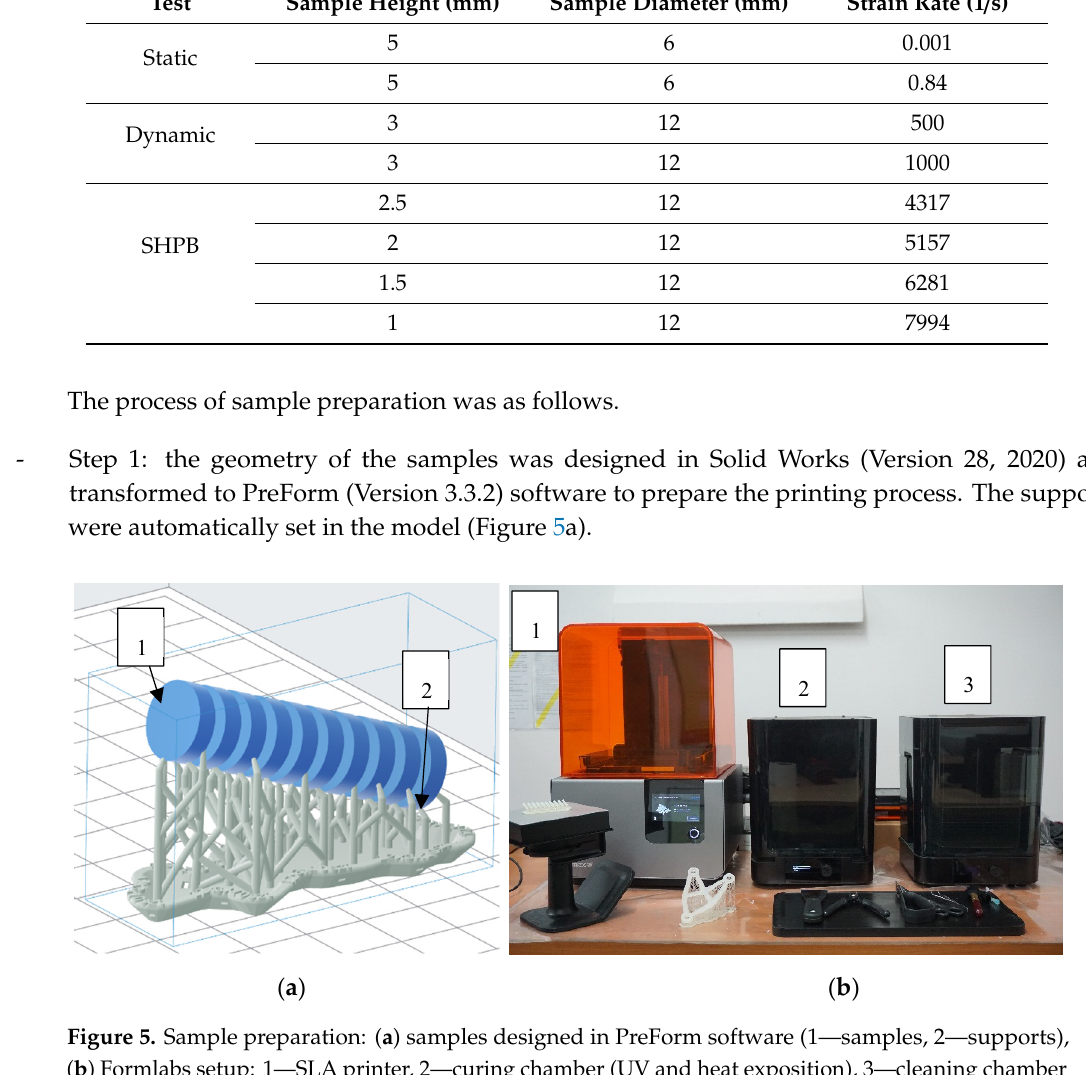
Table 1. Samples dimensions and achieved strain rates.